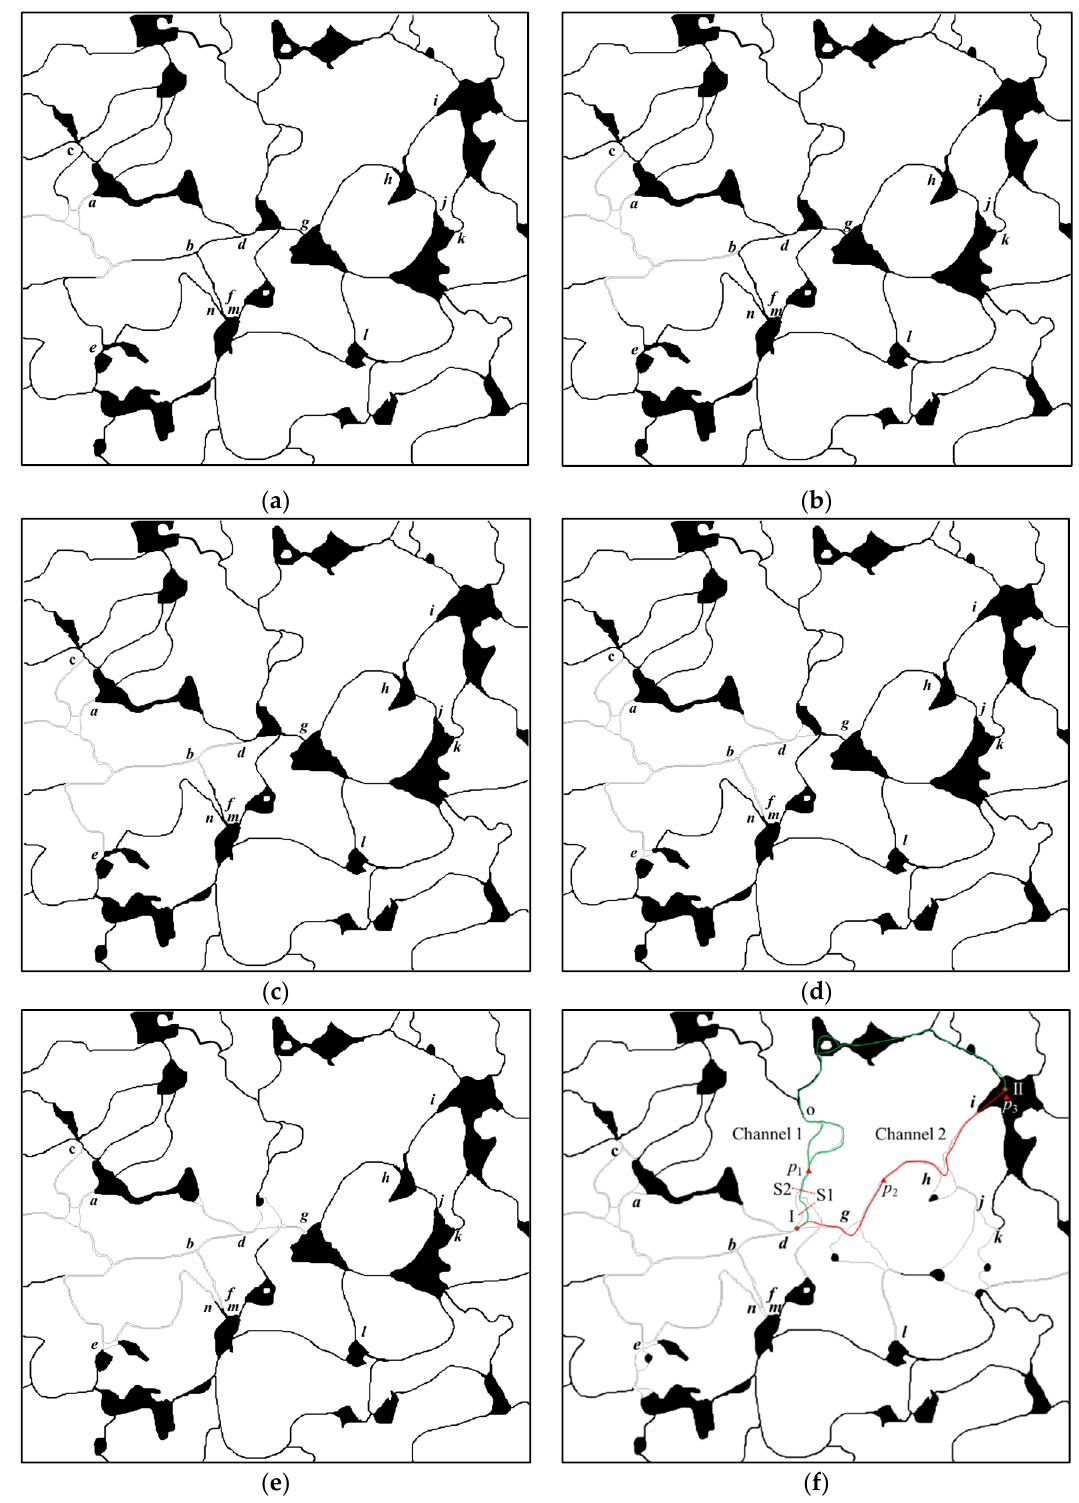
Figure 8. Oil and water distribution at different times, at the injection velocity of 0.005 m · s − 1 (Ca = 7.14 × 10 − 5 ): ( a ) 0.75 s, ( b ) 1.15 s, ( c ) 1.41 s, ( d ) 1.92 s, ( e ) 3 s, ( f ) final. Different positions are indicated by lower case letters .